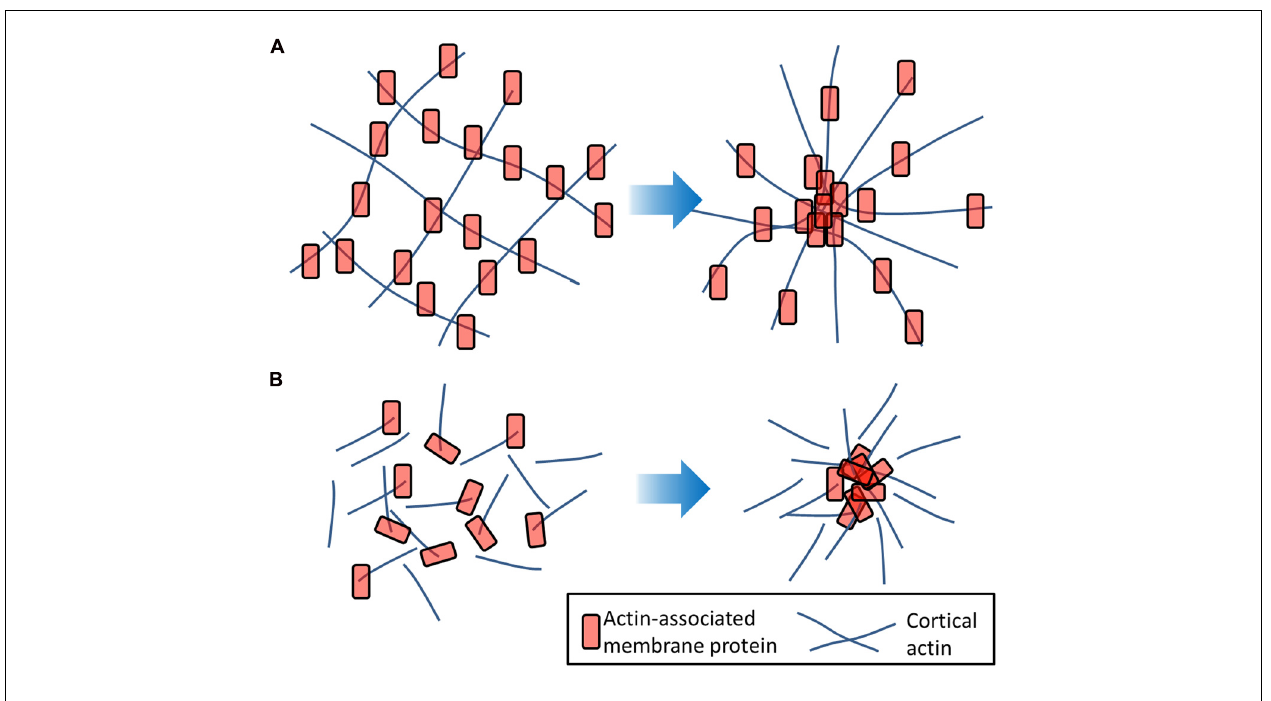
FIGURE 3 |Actin-induced clustering of membrane proteins. (A) Membrane molecules (red) which are tethered to the underlying actin filaments (blue) may undergo transient clustering as the actin mesh flexes.